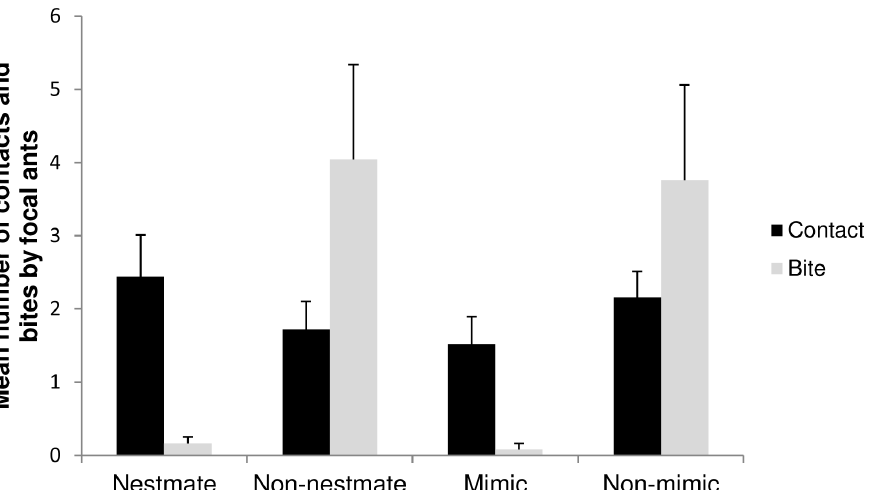
Figure 3. Ant-mimicking spider does not elicit aggressive response from ants: Camponotusnearcticus ants contacted all test subjects equally (Friedman non-parametric ANOVA, F=1.71, P=0.63 d.f.=3), but displayed differences in aggressive response towards them (Friedman non-parametric ANOVA, F=31.12, P=0.0001, d.f.=3). Ants also bit non-nestmate ants significantly more often than they bit their own nestmates (Bonferroni-Dunn test, P , 0.01). In addition, ants bit non-mimic spiders significantly more often than they bit ant-mimic spiders (Bonferroni-Dunn test, P , 0.05).